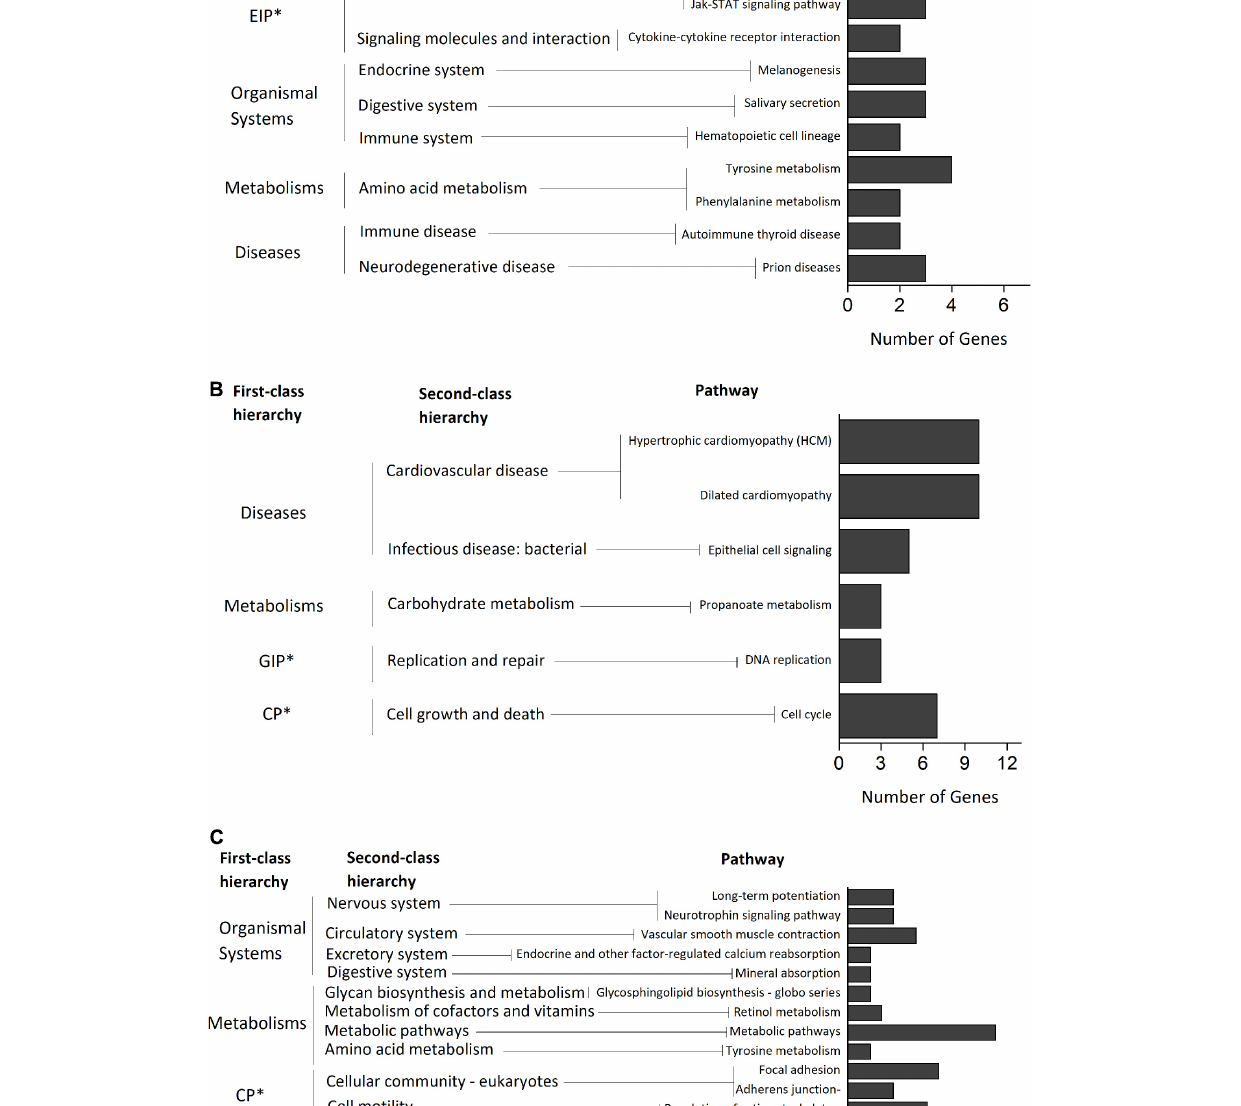
oysters (Yang et al., 2018). In our previous proteomic analysis